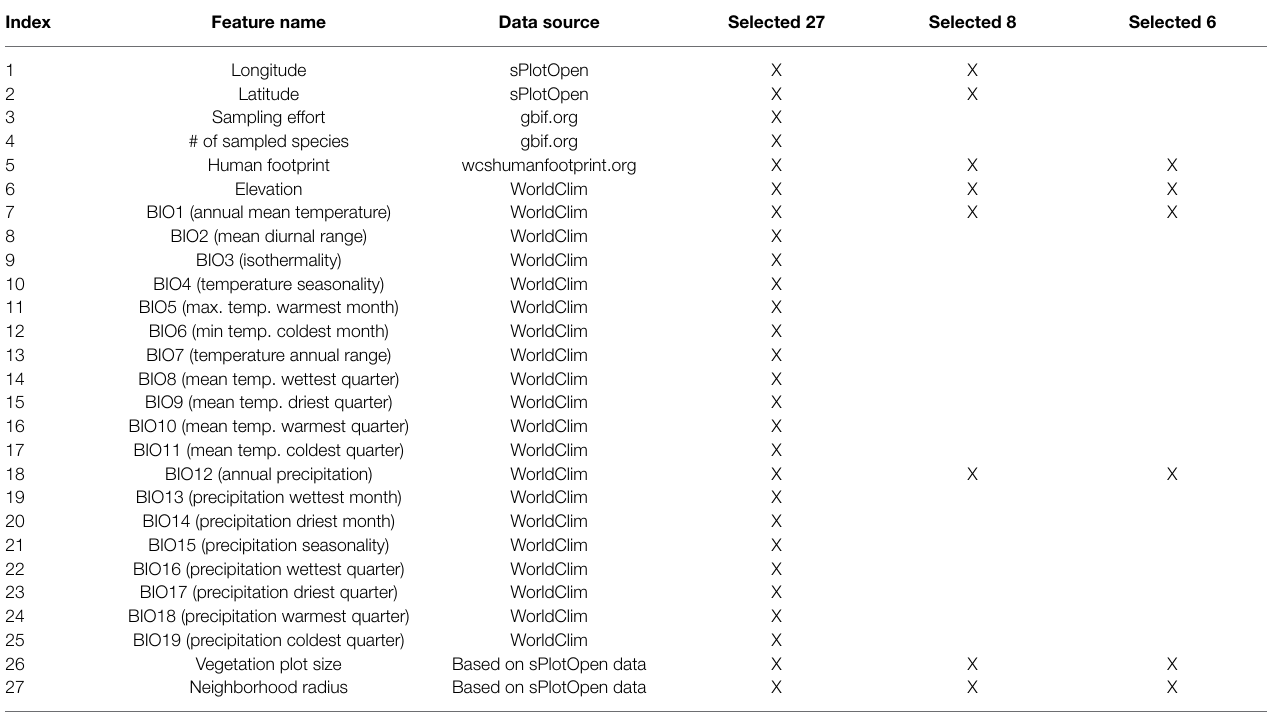
TABLE 1 | Features used in the neural network